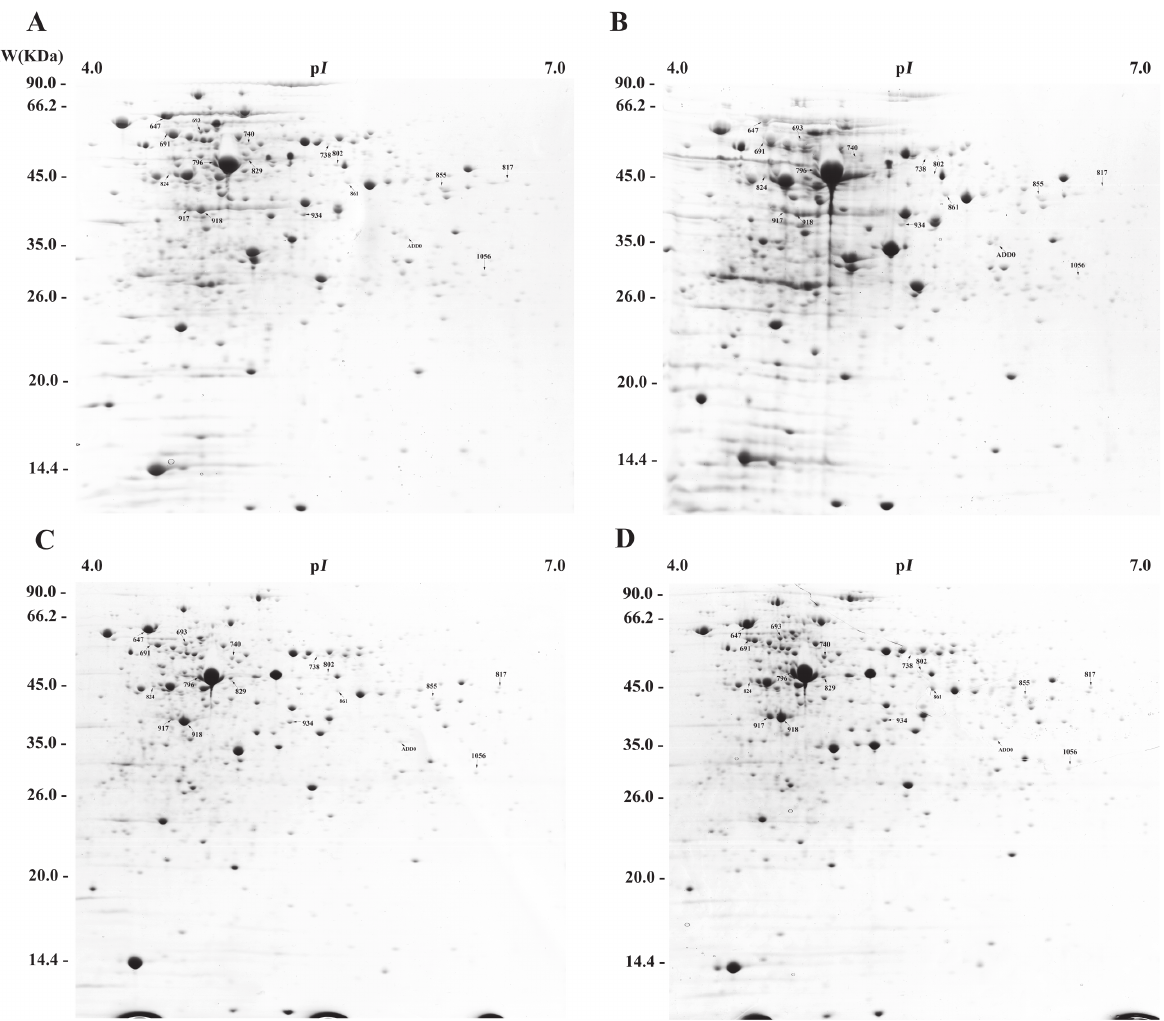
Fig 2. Protein-profiles of Bifidobacteriumlongum subsp. longum BBMN68 cells belonging to the different groups. A, control group; B, pre-stressed group; C, control-pH 3.5 group; D, pre-stressed-pH 3.5 group. Numbers indicate the protein spots of interest, for which information is listed in Table A in S1